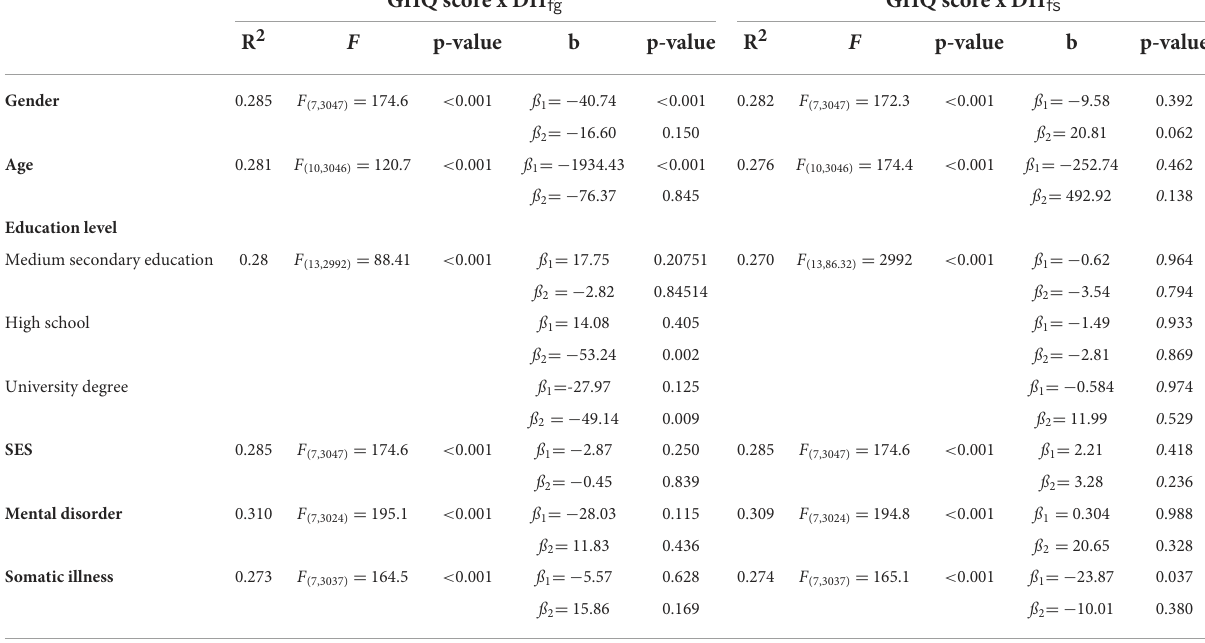
TABLE 2 Moderation analysis—vulnerable groups (controlling for DH fg or DH fs ).